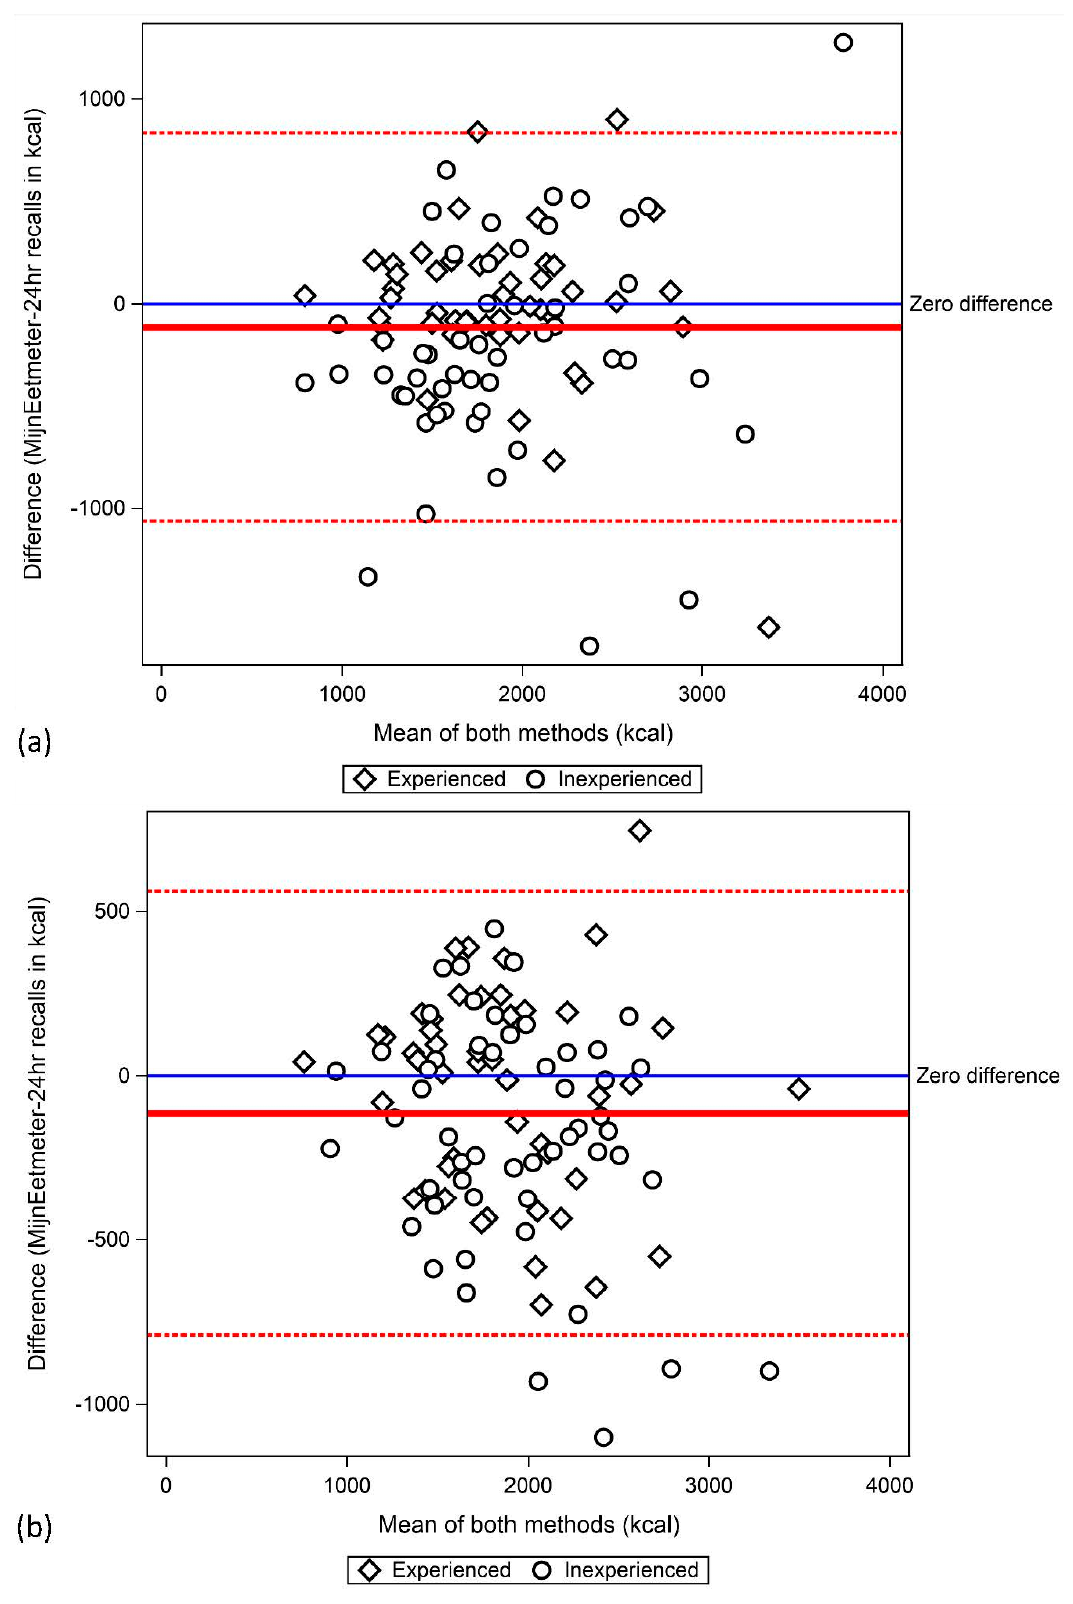
Figure 1. Bland–Altman plot for energy intake assessed with MijnEetmeter and 24-h dietary recalls. ( a ) Results based on one single overlapping day. ( b ) Results based on 3-day means of each method.